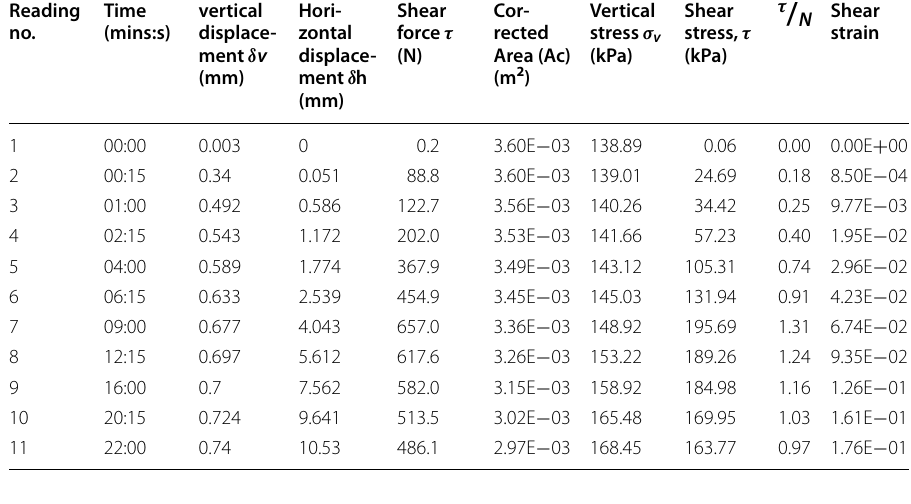
Table 4 Typical computation for test at 138 kPa normal stress for soil–concrete interface for specimen 1 in set 2 Reading no.